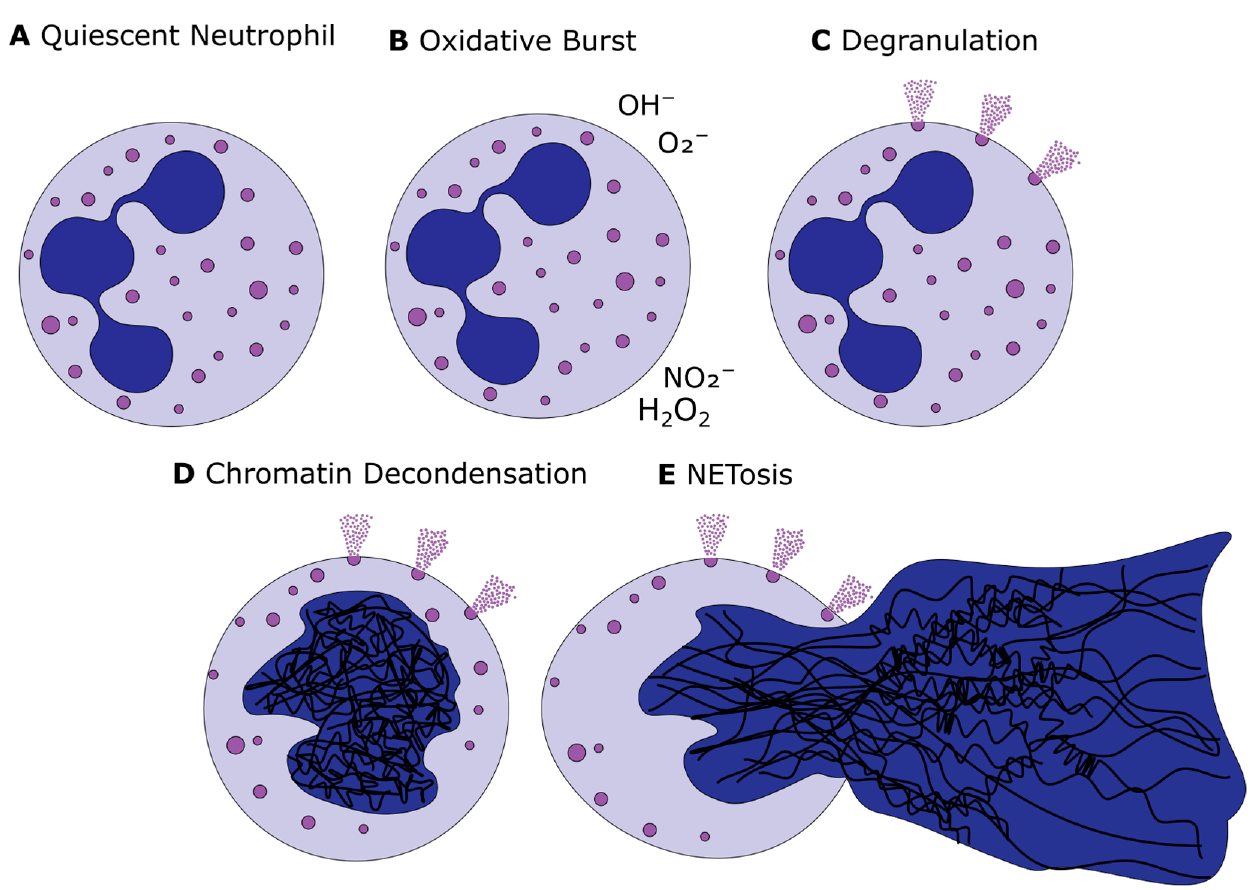
Figure 1. Diagram of neutrophil activation leading to neutrophil extracellular traps (NET)osis. Quiescent neutrophils ( A ) are stimulated by an agonist, resulting in the formulation of reactive oxygen species, known as oxidative burst, that aid in host defense ( B ). Neutrophils undergo degranulation, resulting in the release of a variety of anti-microbial proteins from granules ( C ). As activation proceeds, the nuclear chromatin of neutrophils decondenses from packed lobes into loosely arranged DNA ( D ), and the neutrophil cell membrane eventually ruptures, releasing the DNA as NETs into the extracellular environment ( E ).